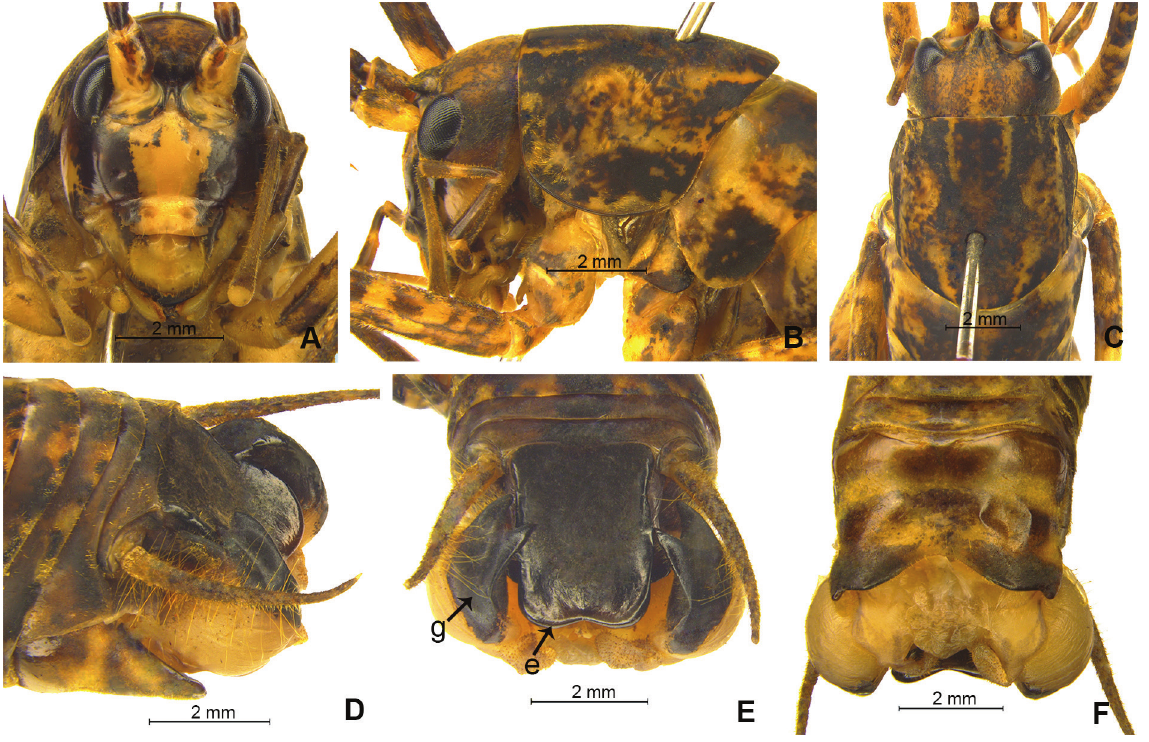
Fig. 4. Megatachycines trispinosus (Qin & Li, 2020) comb. nov. ♂. A–C . Head and pronotum. A . Frontal view. B . Lateral view. C . Dorsal view. D–F . Apex of abdomen. D . Lateral view. E . Dorsal view. F . Ventral view. Abbreviations: e = epiproct; g = dorso-lateral lobes of